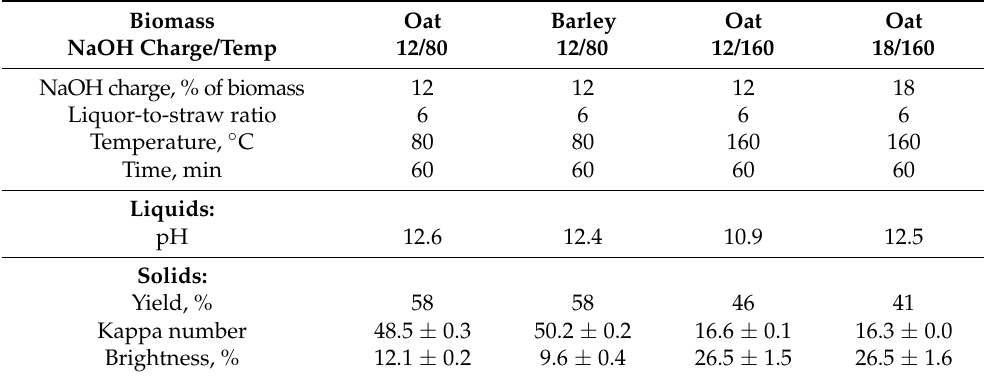
Table 3. Conditions and results in the straw processing experiments.